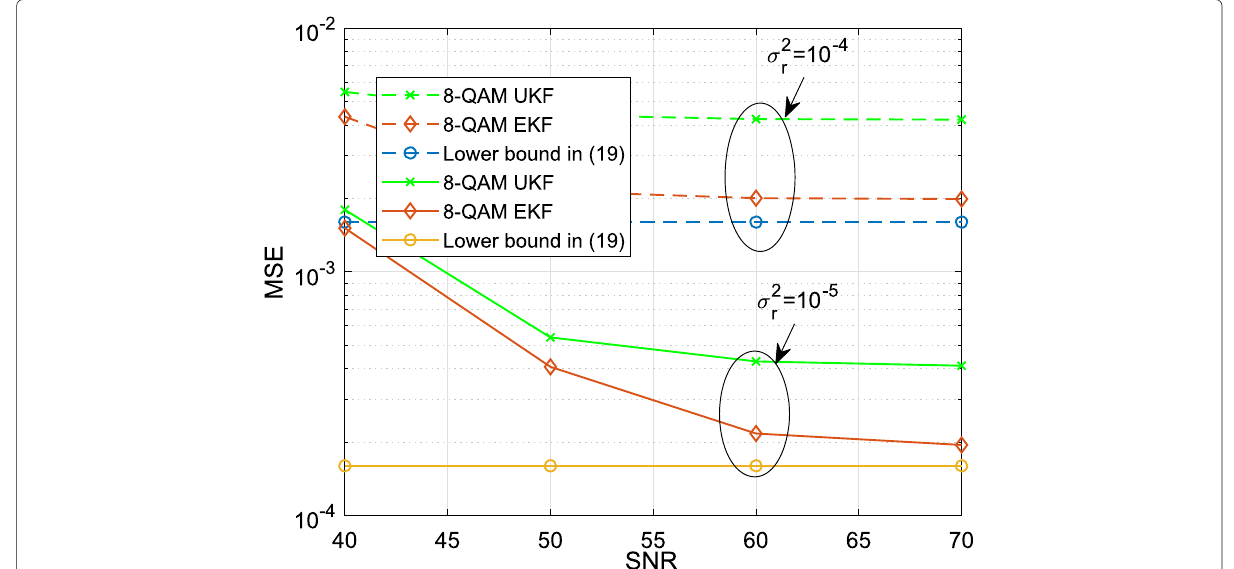
= 10 − 4 ,10 − 5 and 8–QAM modulation for a 2 × 2 FD MIMO SI